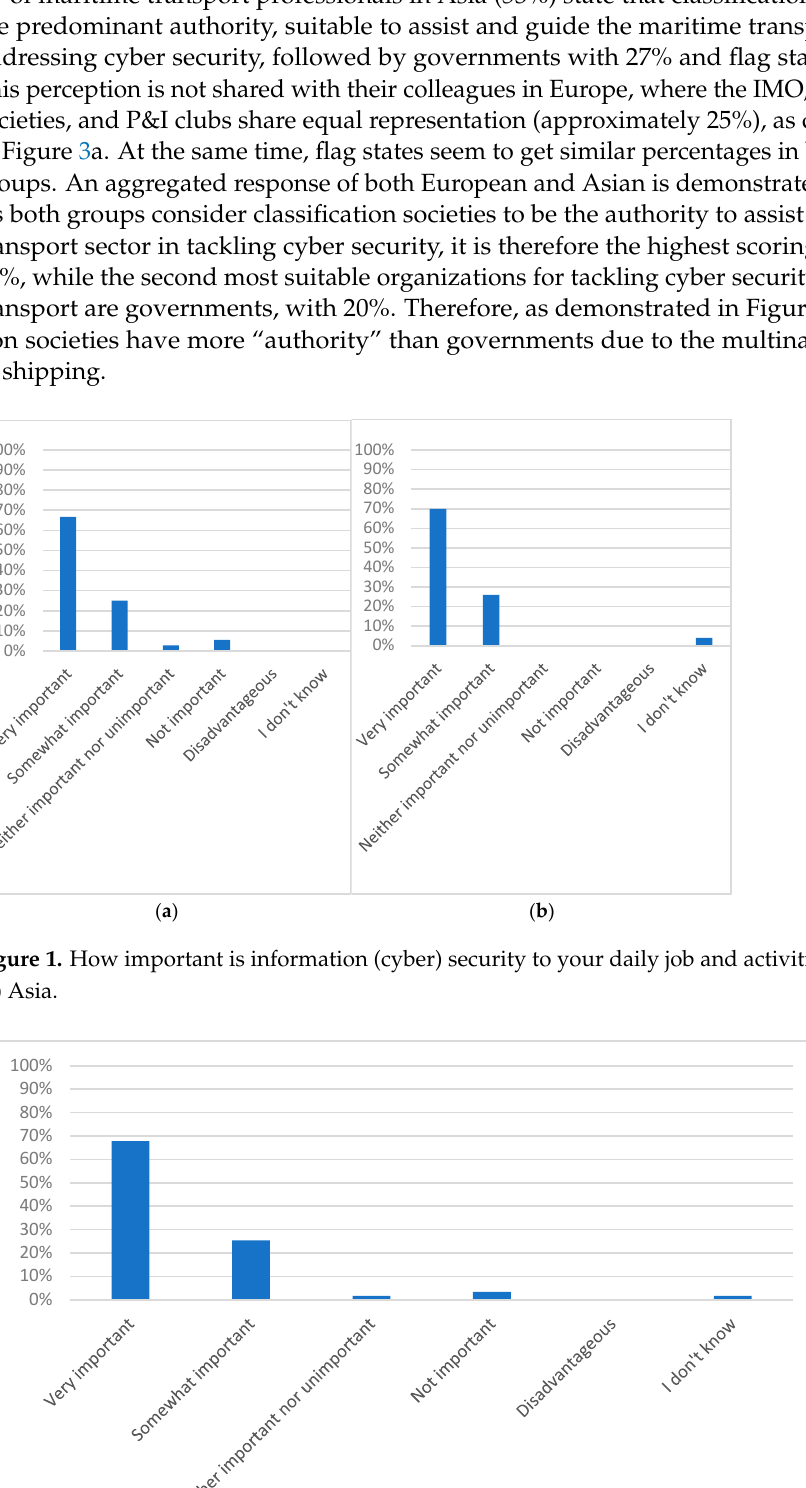
Figure 2. How important is information (cyber) security to your daily job and activities? (Asia and Europe).